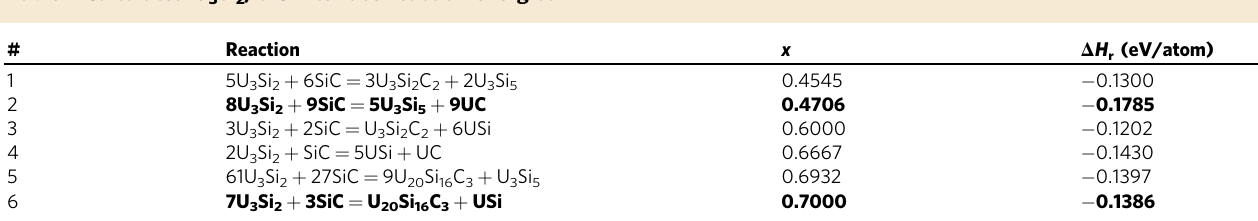
Table 1 Calculated U 3 Si 2 /SiC interface reaction